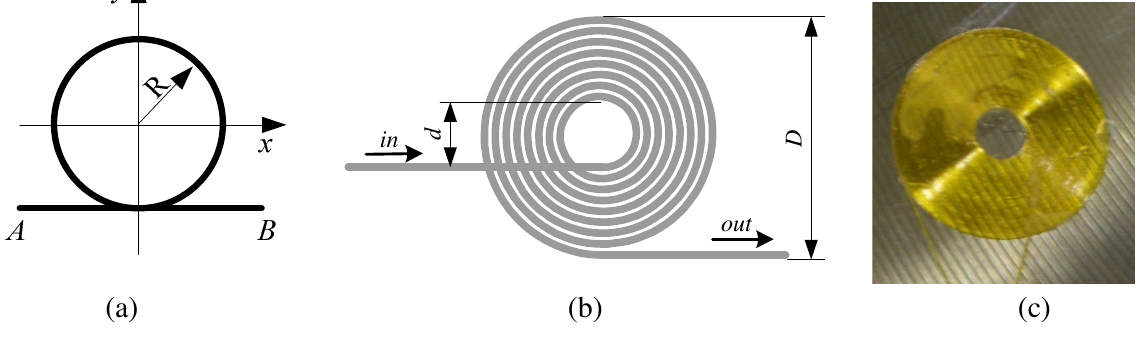
Figure 1. (a) The circular loop FOD sensor. (b) Sketch of the spiral FOD sensor. (c) Picture of a surface-bonded spiral FOD